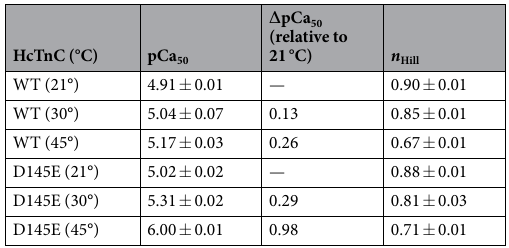
Table 1. Ca 2 + binding to HcTnC D145E and WT proteins labeled with IAANS increases with temperature, and the mutant is more susceptible. Proteins were labeled at Cys 35 and Cys 84 with IAANS, dialysed into fluorescence buffer containing EGTA, nitriloacetic acid, MOPS and KCl ( see Methods ) and adjusted to 1 µ M before adding 1 mM MgCl 2 and 1 mM DTT. After 10 min equilibration at the indicated temperature, proteins were titrated with CaCl 2 . pCa 50 ( − log of [Ca 2 + ] for 50% of maximum fluorescence) and n Hill are from Fig. 6A and B or (for 21 °C) from Pinto et al . 10 . Data reported at 21 °C were not tested against the others. Errors are ± s.e.m. (n = 4–5 at 21° and n = 4 at 30° and 45 °C). pCa 50 values at the same temperature (30°C or 45°C) and n Hill values at 45°C are significantly different for the two proteins (p < 0.02). pCa 50 values for D145E are significantly different (p < 0.02) at 30° and 45°C. n Hill values for the same protein are significantly different (p < 0.02) at 30° and